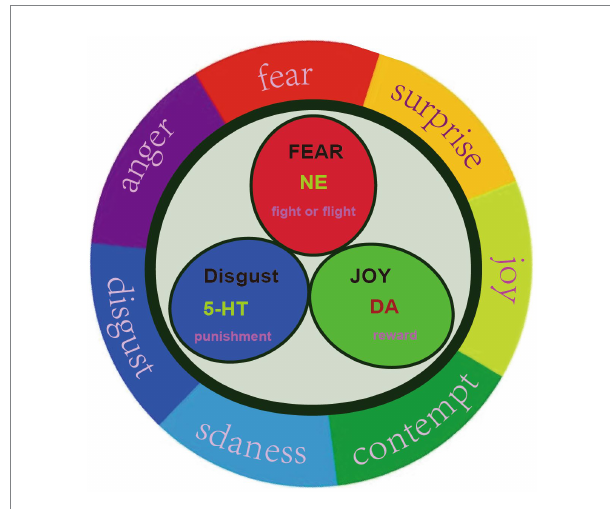
FIGURE 2 Three primary basic emotions. Russell proposed that all emotions can be located on a circle, instead of a quadrant. We proposed that there might be three primary emotions (Joy, fear, and sadness), adopted from our previous paper